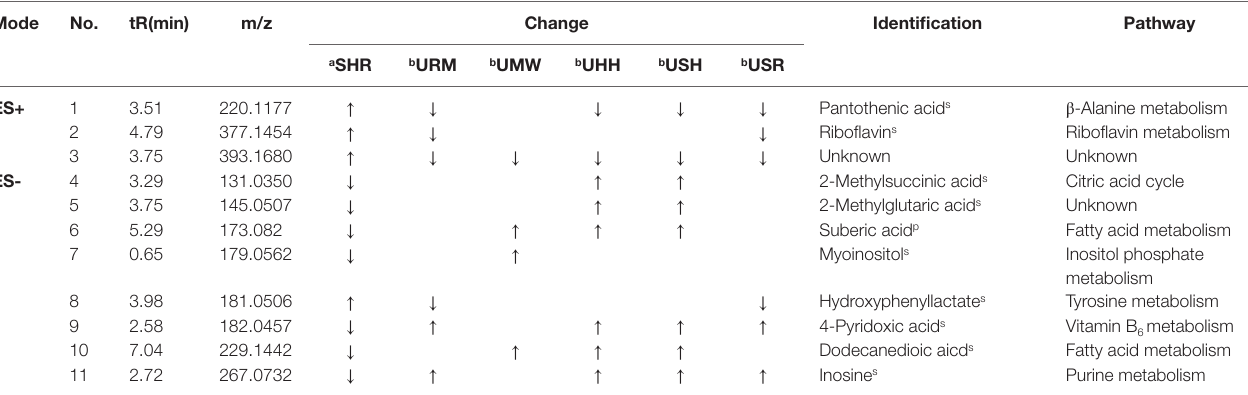
TABLE 2 | Eleven identified potential biomarkers between the seven groups; ( ↑ ): upregulated, ( ↓ ): downregulated. Mode No. tR(min) m/z Change